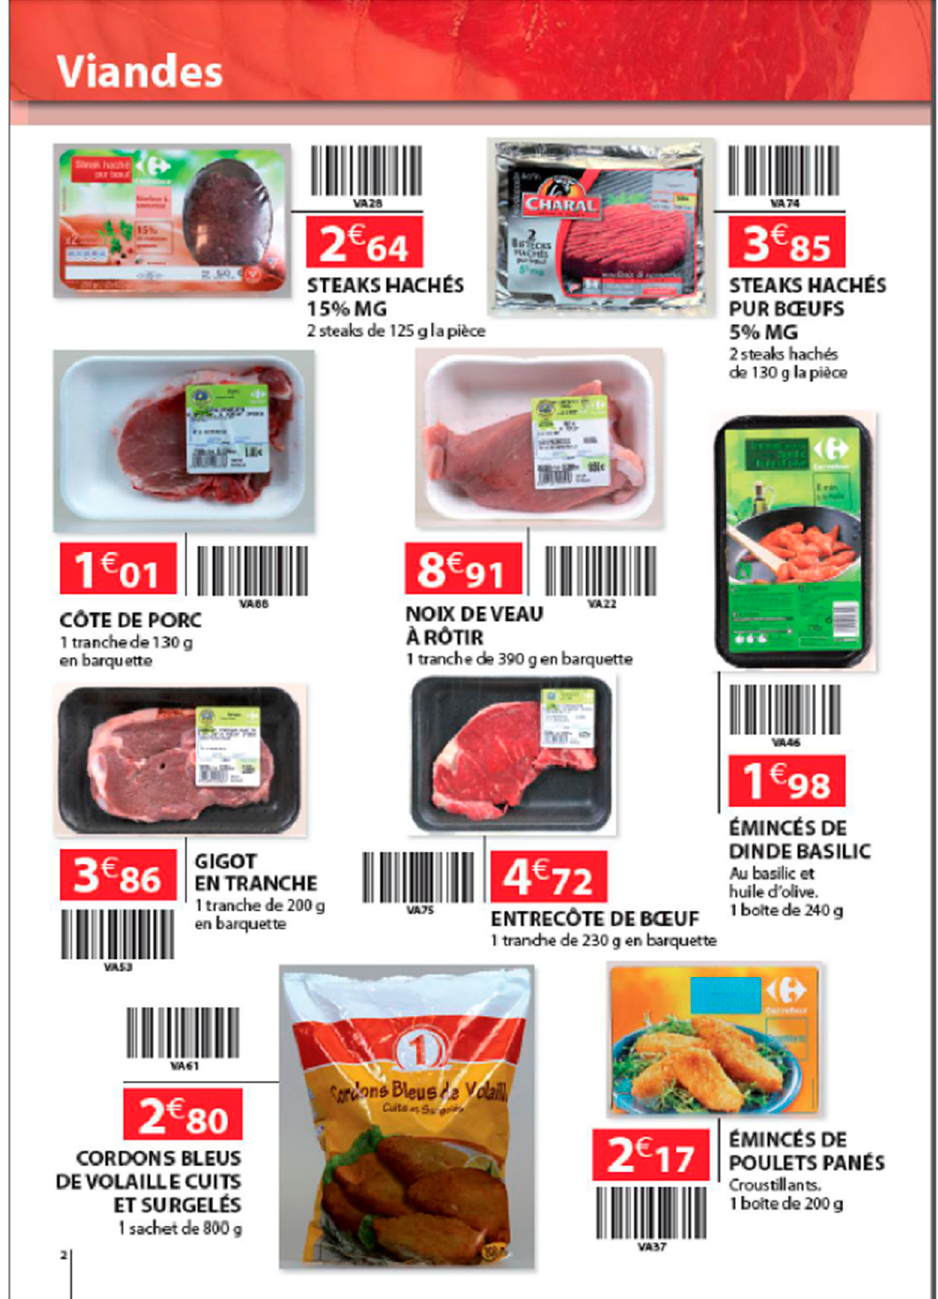
Figure A15. Food catalogue with no label—Example of one page: the meat category.